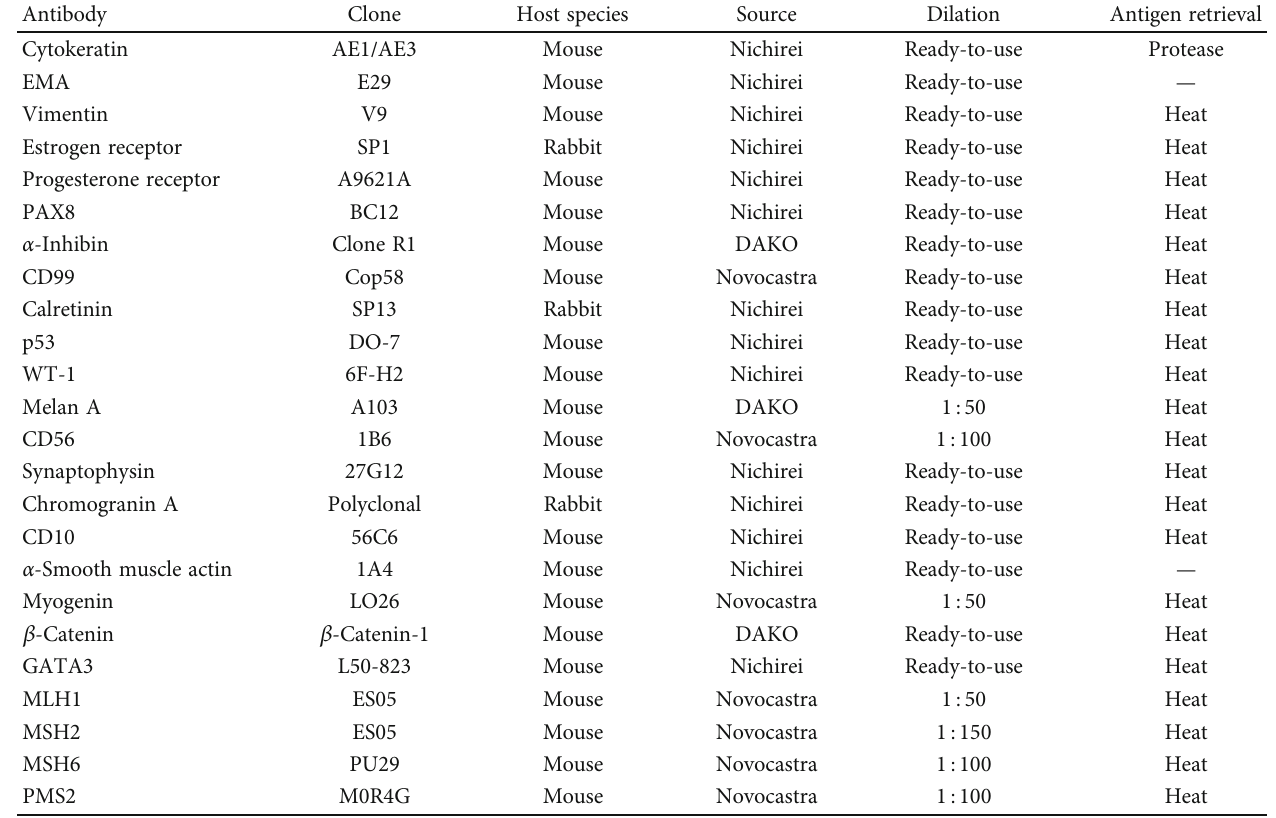
Table 1: Primary antibodies used for